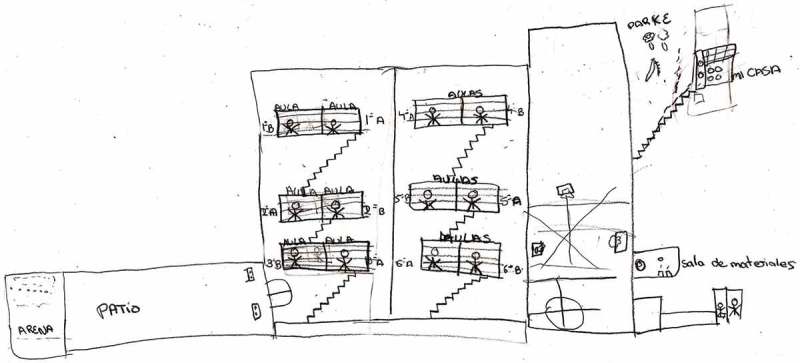
Girl, urban area.jpg.